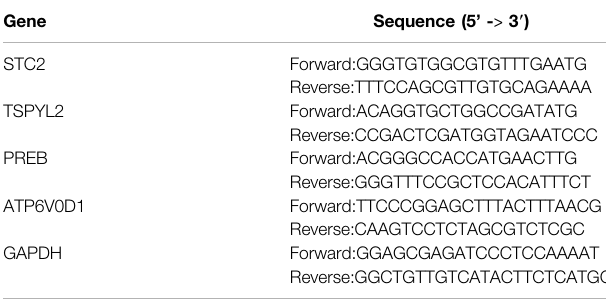
TABLE 1 | Primer sequences of the candidate